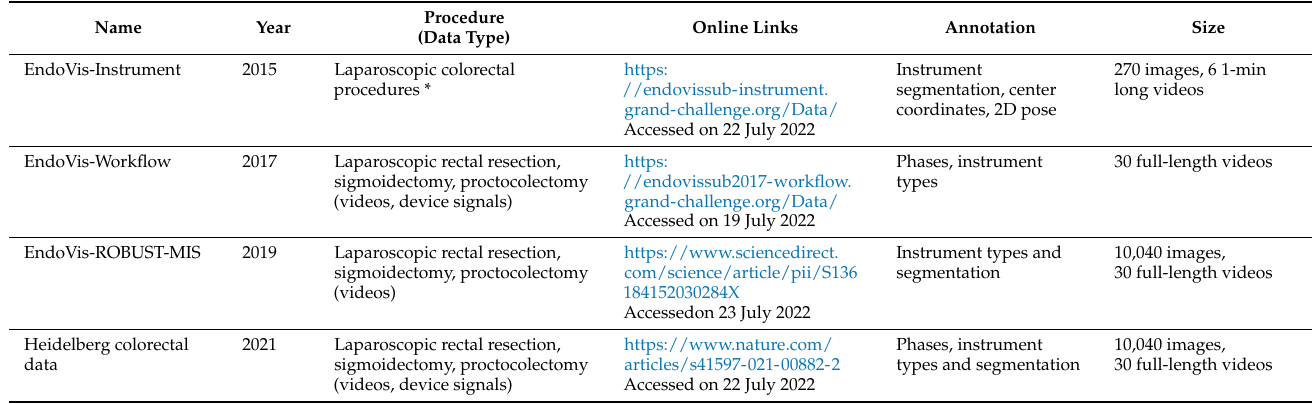
Table 1. Publicly available annotated datasets of colorectal surgery procedures. The dataset coming from Heidelberg University Hospital has grown in size and annotation types over the years and editions of Endoscopic Vision (EndoVis) challenge, a popular medical computer vision challenge organized at the International Conference on Medical Image Computing and Computer Assisted Intervention